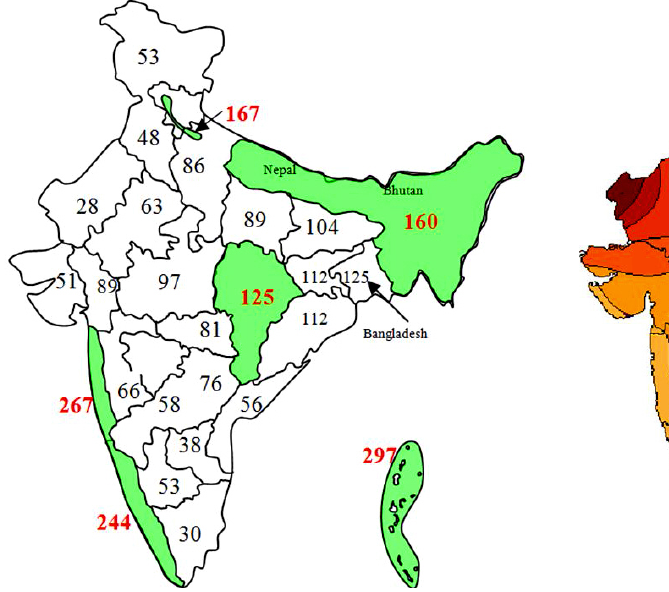
Figure. 3 Normal distribution of monsoon in India in cm (after K.N. Rao), based on Hawkins 1986 and additional inputs from http://www.rainwaterharvesting.org/urban/rainfall.htm Green areas show rainfall more than 125cm; preferred habitat of Euthalia aconthea